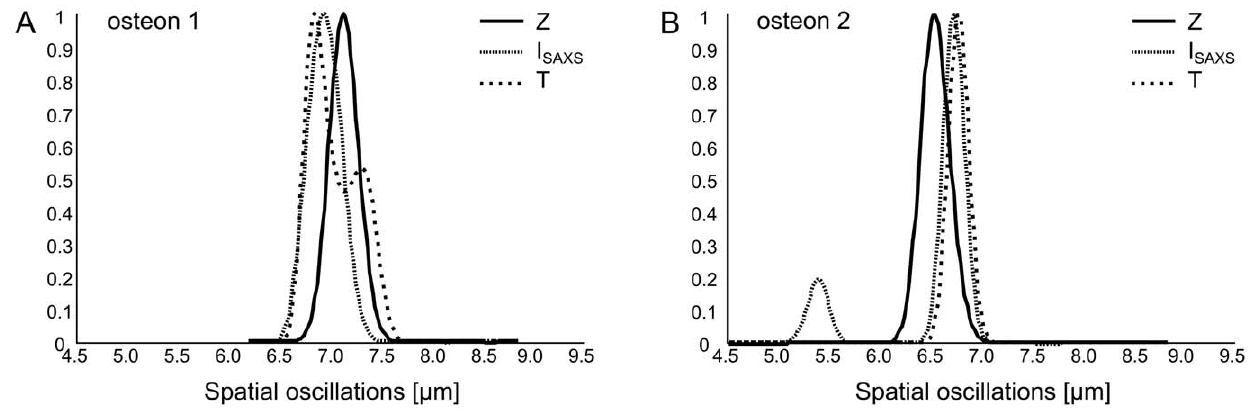
doi:10.1371/journal.pone.0058043.g004